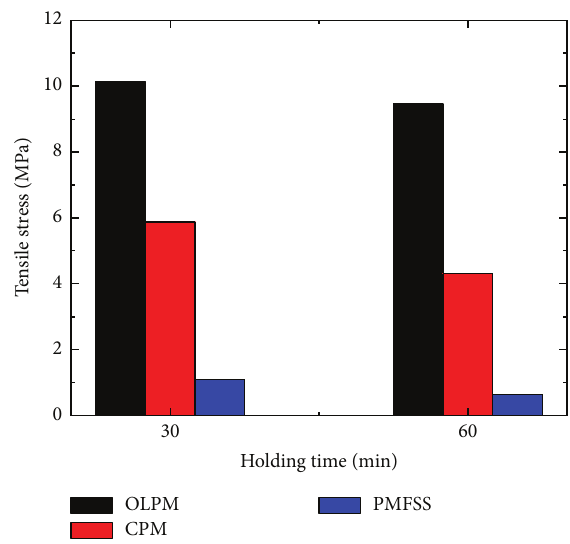
Figure 12: Tensile strength of three different porous